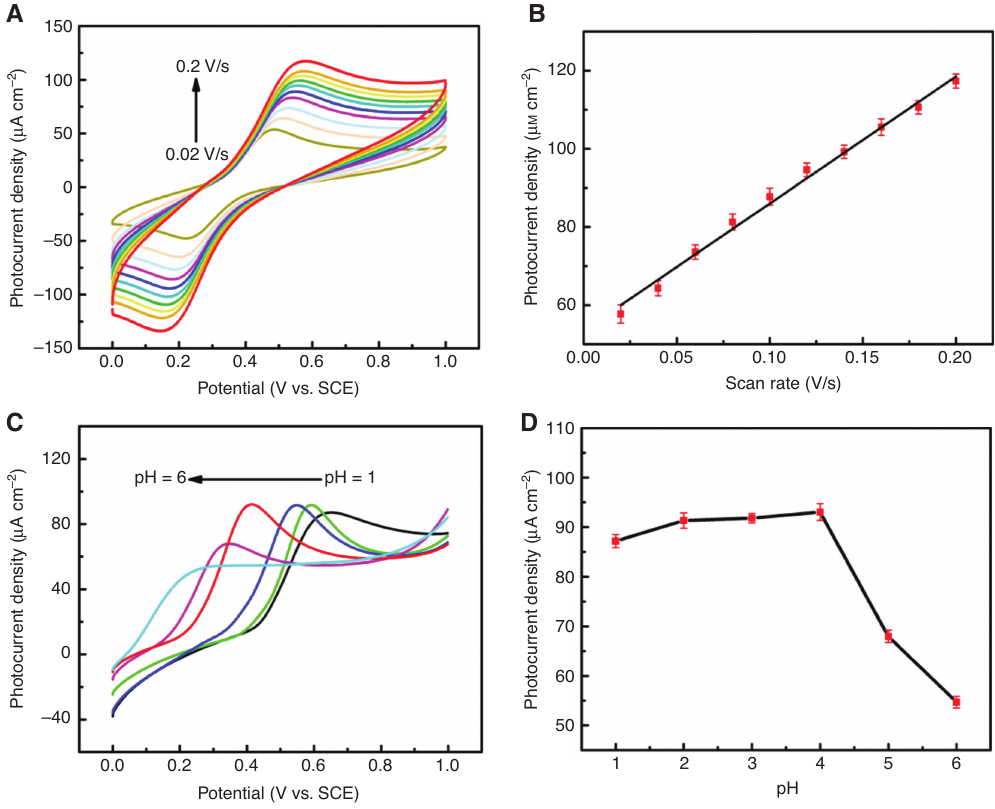
Figure 5: The concentration of NGQDs dispersion is 0.5 mg/ml. CVs of NGQDs/GCE in BR buffer solution (pH 4.0) solution containing 0.1 mm DA under UV light illumination at scan rates from 0.02 to 0.2 V s −1 (A) and the plots of anodic peak photocurrent density vs. the scan rates (B) and LSVs of NGQDs/GCE in BR buffer solution containing 0.1 mm DA under UV light illumination at pH 1.0–6.0 (C) and the plots of the anodic peak density vs. pH (D).